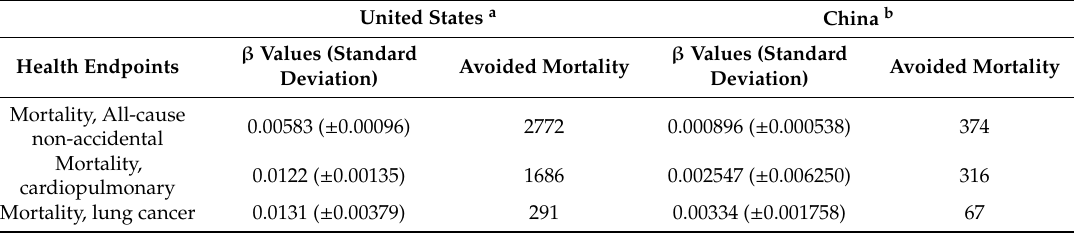
Table 4. Avoided deaths in Bangkok from a 10 µ g / m 3 rollback of PM 2.5 in the year 2016.